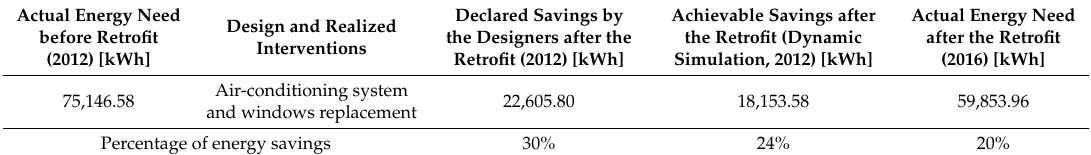
Table 8. Comparison between declared, achievable and actual energy uses (Building